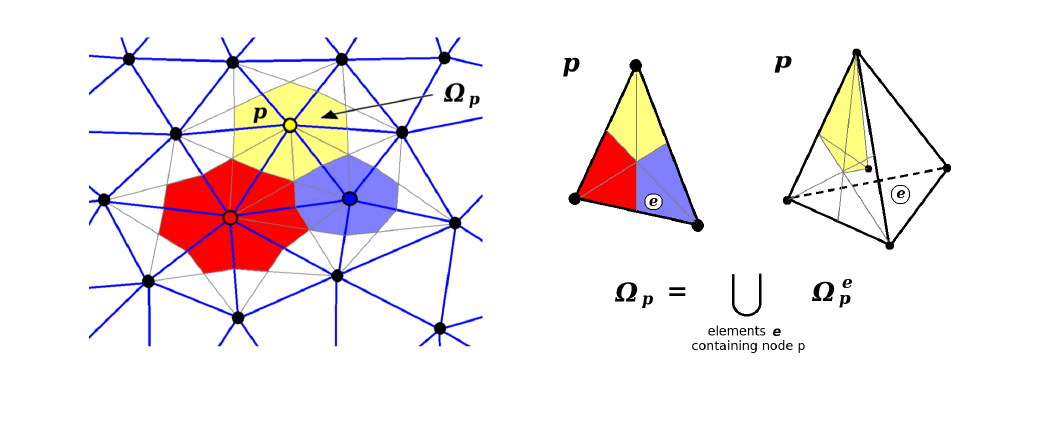
Figure 2. Definition of nodal subdomains in 2D and